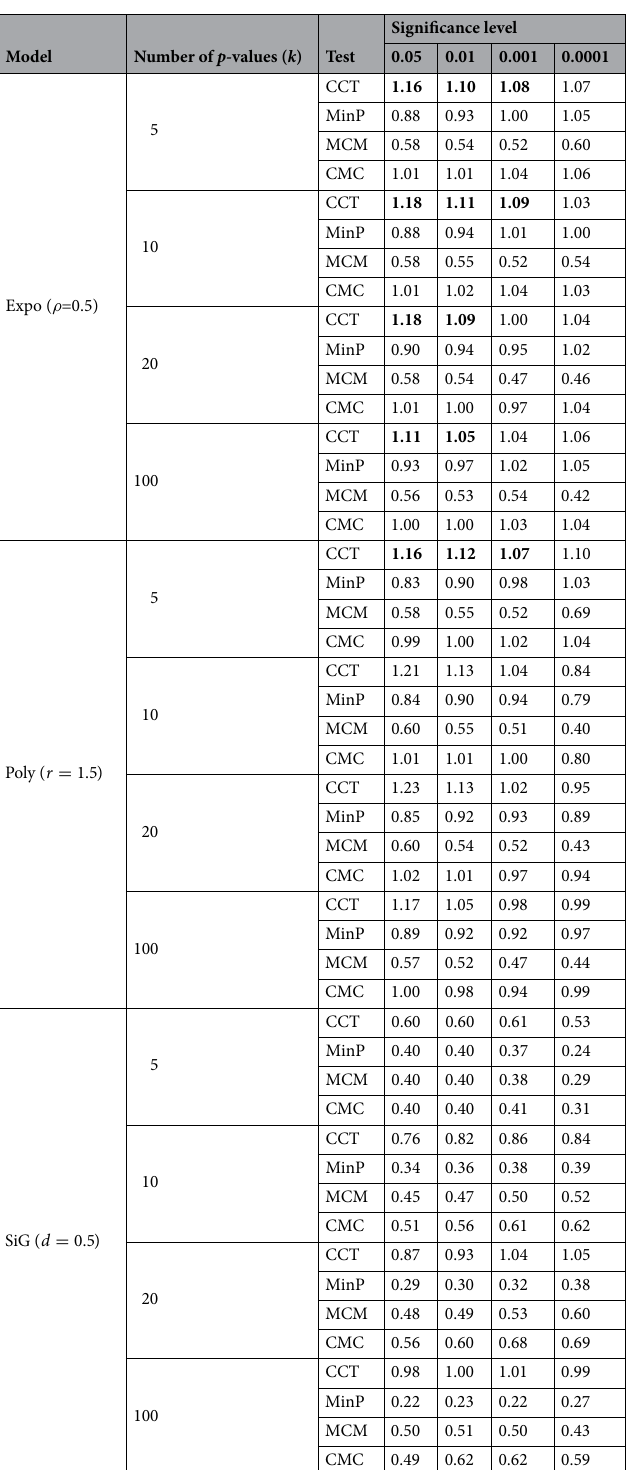
Table 1. Empirical type I error rate (/significance level) using 1e 6 replicates, highlighted bold are the values greater than the significance level and outside of the 95%